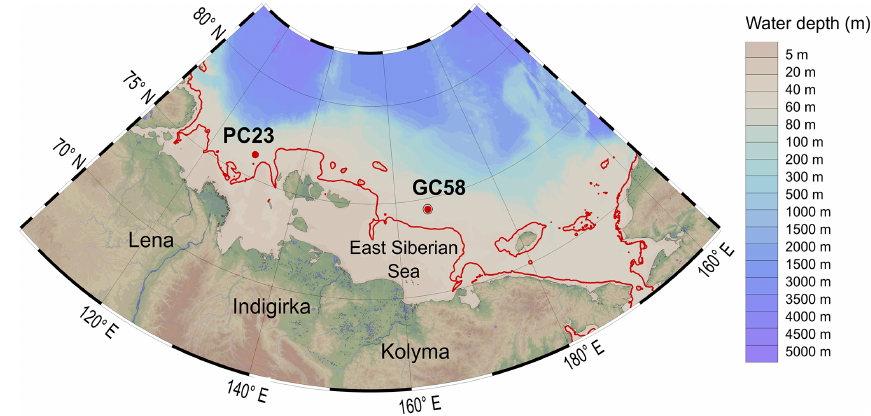
Figure 1. Map of the East Siberian Arctic Shelf showing the location of the sampling site (station SWERUS C3-1-58; Schlitzer, 2015). Also shown in the map is the location of the sediment core PC23 (station SWERUS C3-1-23; Tesi et al., 2016a). The red line marks the isobath (34m of water depth), which is approximately where the coastline was at the beginning of the sediment archive (GC58) ∼ 9500calyrs BP (Lambeck et al.,